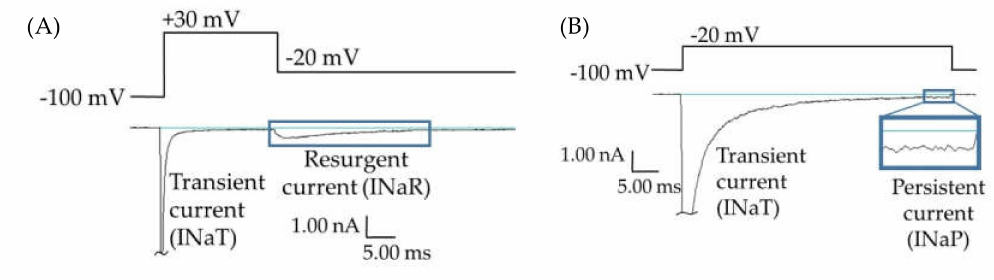
Figure 1. Persistent and resurgent currents. ( A ) A raw current trace from a human embryonic kidney (HEK) cell expressing hNav1.2 cDNA. Peak resurgent current (blue box) was measured as the peak current occurring during the repolarization pulse in the resurgent current voltage protocol (single step from the protocol shown above the trace). ( B ) A raw current trace from an HEK cell expressing hNav1.2 cDNA. Peak persistent current (blue box) was measured as the average current over the last 5 ms of a 50 ms depolarization pulse (shown above the trace). Inset shows persistent current, amplified 5 × . Both persistent and resurgent currents have been shown to occur naturally in mammalian